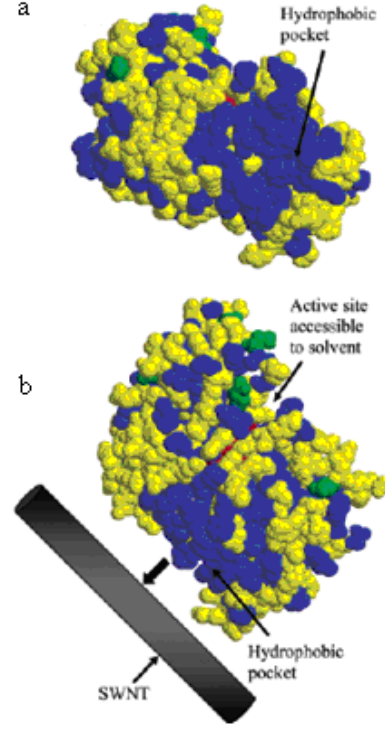
Figure 5. (a) PDB structure of SBP showing the hydrophobic pocket. Hydrophobic and hydrophilic residues are shown in blue and yellow, respectively, while the asparagines residues that are glycosylated are shown in green and the heme is shown in red. (b) A schematic hypothesizing the adsorption of SBP onto SWNTs via the hydrophobic pocket on SBP (reproduced with permission [31] © 2004, American Chemical